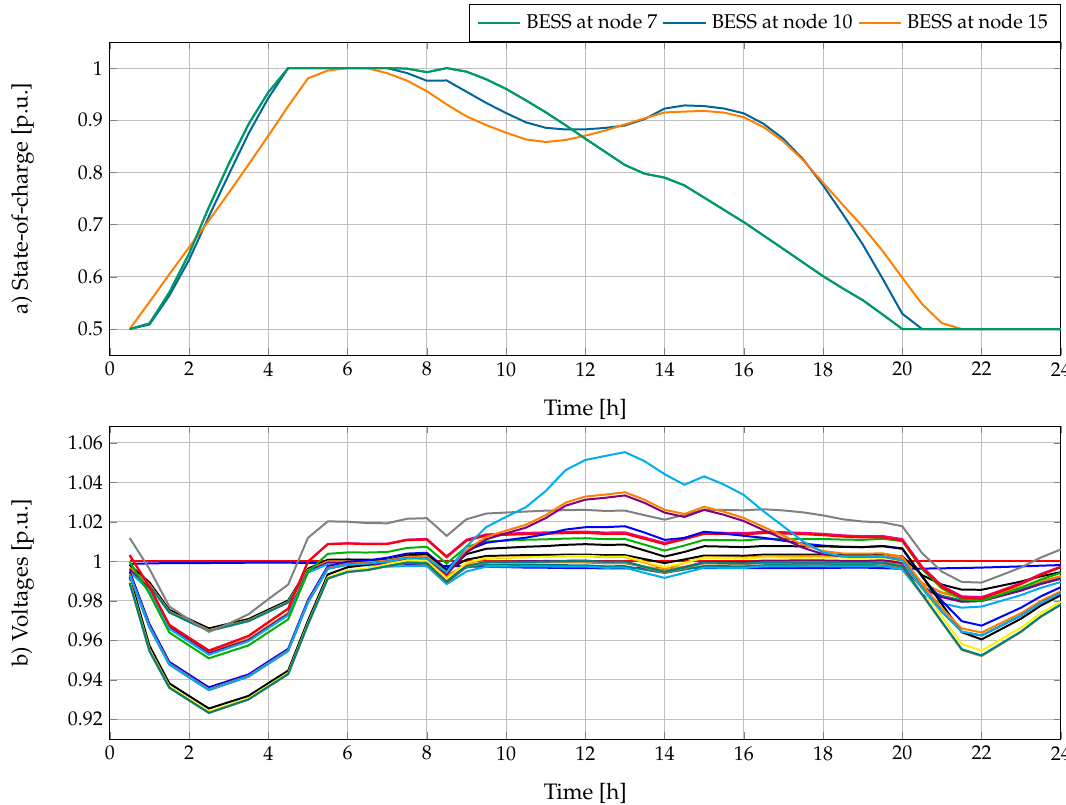
Figure 5. State-of-charge of the BESSs and voltage profiles during a daily operation: ( a ) states of charge; and ( b ) voltage